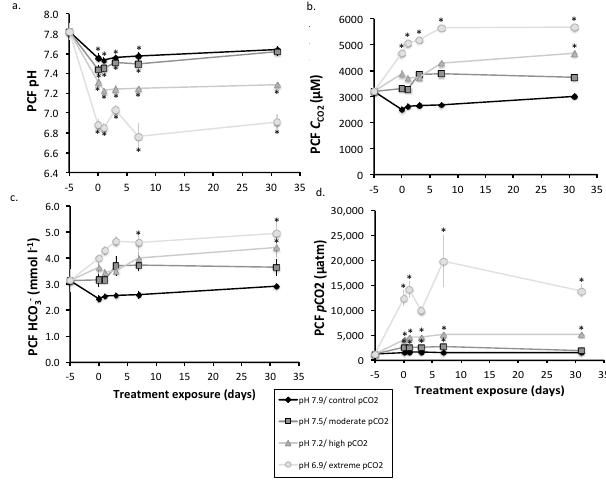
Figure 2. During experiment one, S. fragilis perivisceral coelomic fluid (PCF) pH and C CO2 2 Fig. 2. During experiment one, S. fragilis perivisceral coelomic were measured (a and b, respectively), and HCO 3- and p CO 2 were calculated (c and d, 3 fluid (PCF) pH and C CO were measured ( a and b , respectively), 2 respectively) as described in the text. Statistically significant differences from pre-treatment 4 and HCO − and p CO 2 were calculated ( c and d , respectively) as 3 (day “-5”) values were evaluated by ANOVA followed by Tukey’s HSD test, and are shown 5 described in the text. Statistically significant differences from pre- with * denoting P <0.05. 6 treatment (day “ − 5”) values were evaluated by ANOVA followed by Tukey’s HSD test, and are shown with ∗ denoting P < 0 .